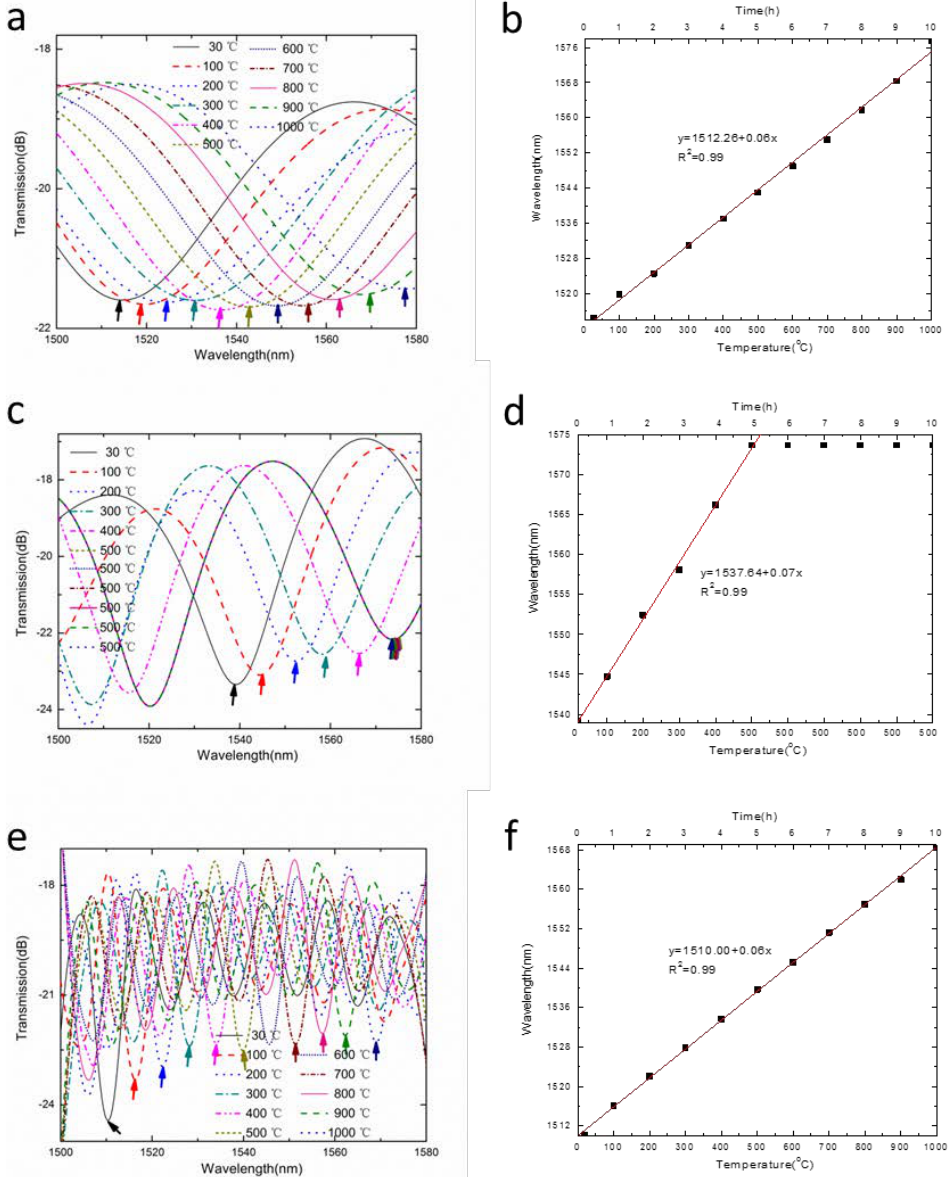
Figure 10. The drift of MZI spectra and corresponding temperature response at different furnaces. ( a , b ) correspond to the first furnace; ( c , d ) correspond to the second furnace; ( e , f ) correspond to the third furnace.